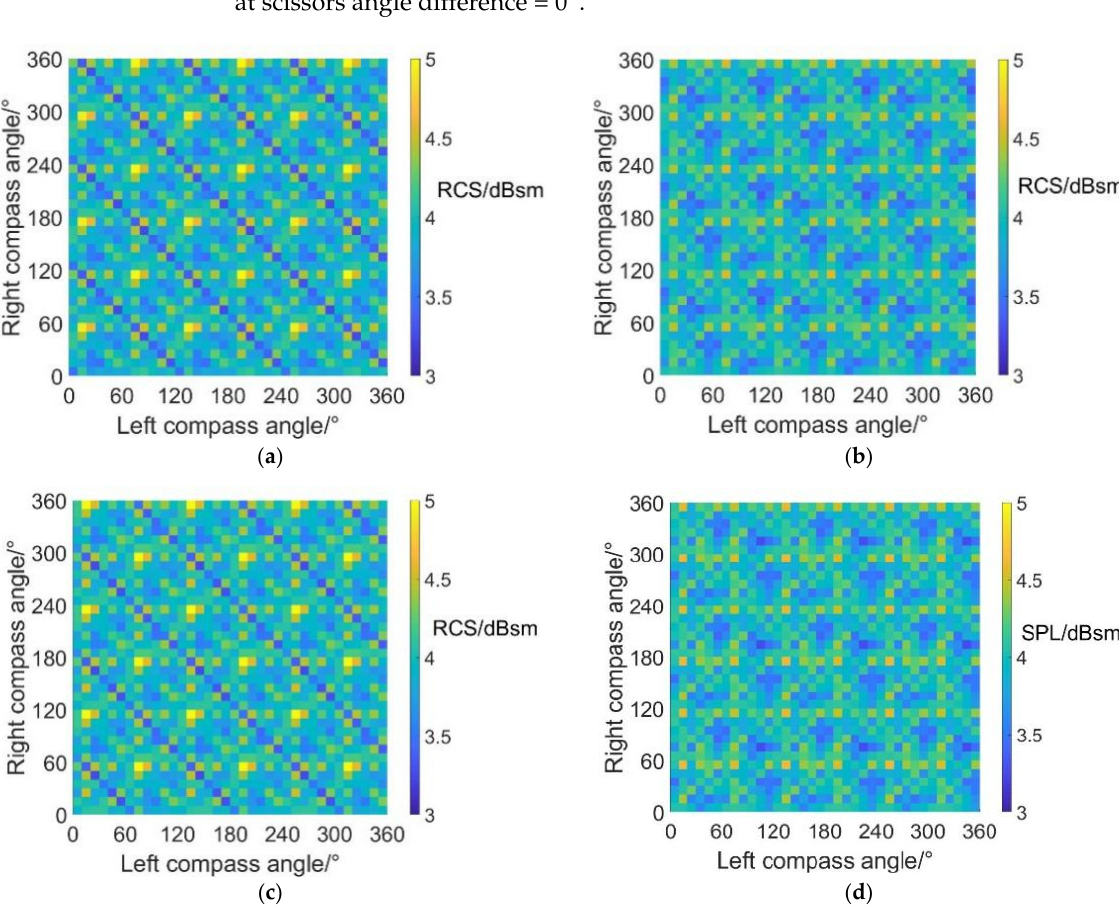
Figure 19. Carpet diagrams of average RCS in fixed-wing mode at an azimuth angle = 0° with scissors angle difference = ( a ) 0°, ( b ) 30°, ( c ) 60°, ( d ) 90°.